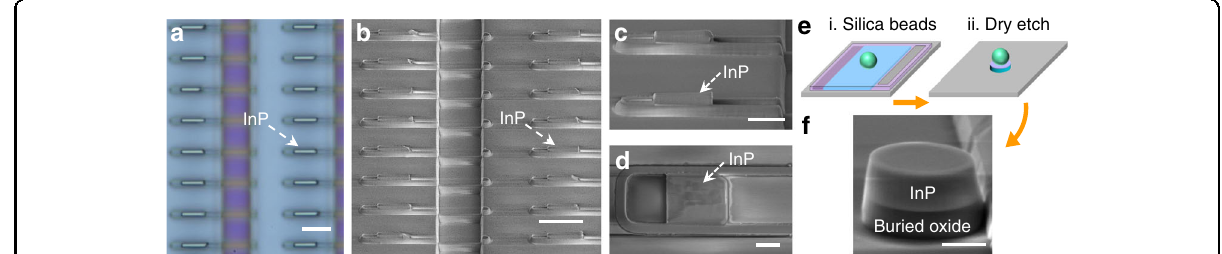
Fig. 5 Laser demonstrations using the epitaxial InP sub-micron wires and membranes. a Optical microscope image of InP subwavelength wire lasers with 500 nm pattern length after top oxide and Si removal. Scale bar, 5 µm. b 52° tilted SEM image of InP subwavelength laser array on SOI by 500 nm pattern length. Scale bar, 5 µm. c 52° tilted SEM image of subwavelength lasers. Scale bar, 2 µm. d Top-view SEM image of the square cavity laser. Scale bar, 1 µm. e Schematic of process fl ow of micro-disk lasers. f 70° tilted SEM image of fabricated micro-disk laser on SOI. Scale bar, 500